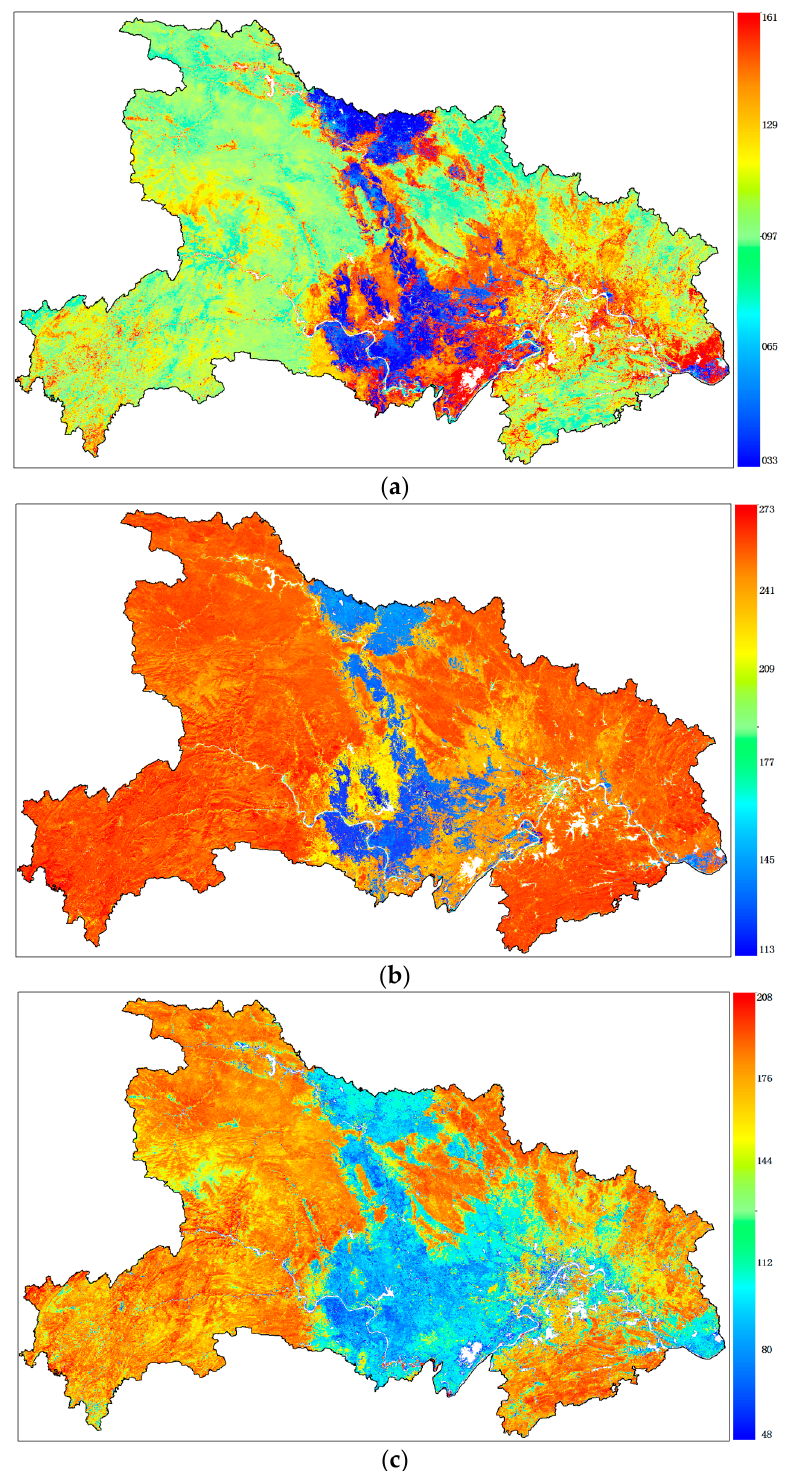
Figure 6. Three phenological parameters, ( a ) start of season (SOS), ( b ) end of season (EOS) and ( c ) length of season (LOS) of the first season in 2015. Color bars in ( a , b ) indicate the day of a year (DOY) and color bar in ( c ) indicates the length of a season in days.